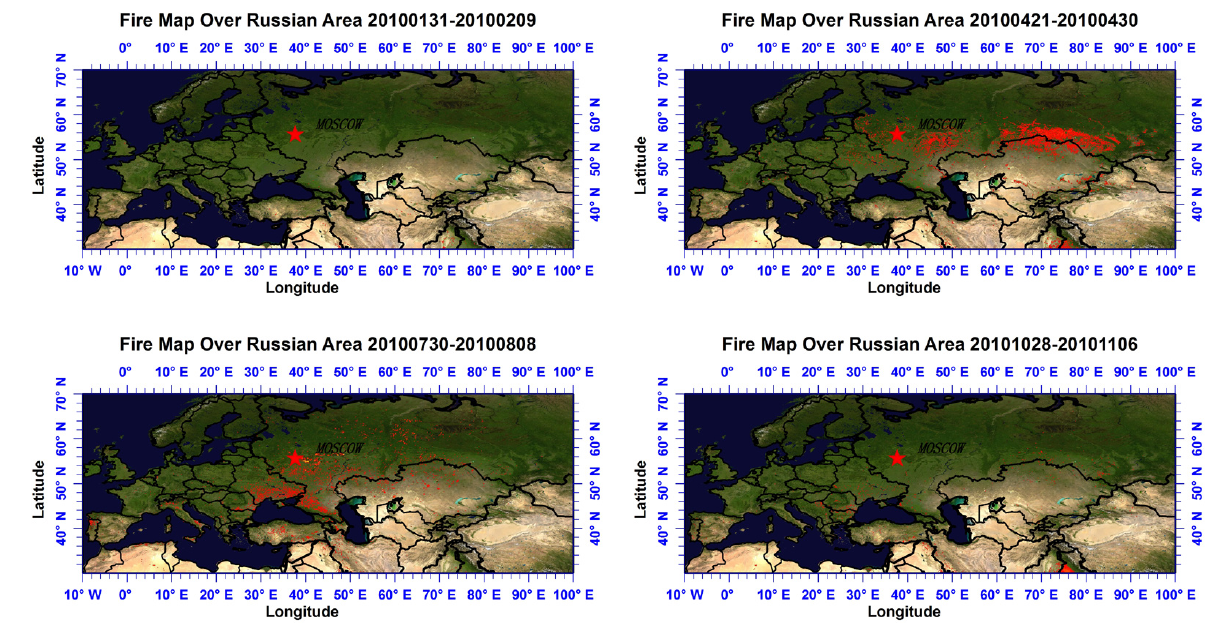
Fig. 1. 10-day Fire map over Russian area in short periods in different seasons (http://maps.geog.umd.edu/firms/kml.htm#russia